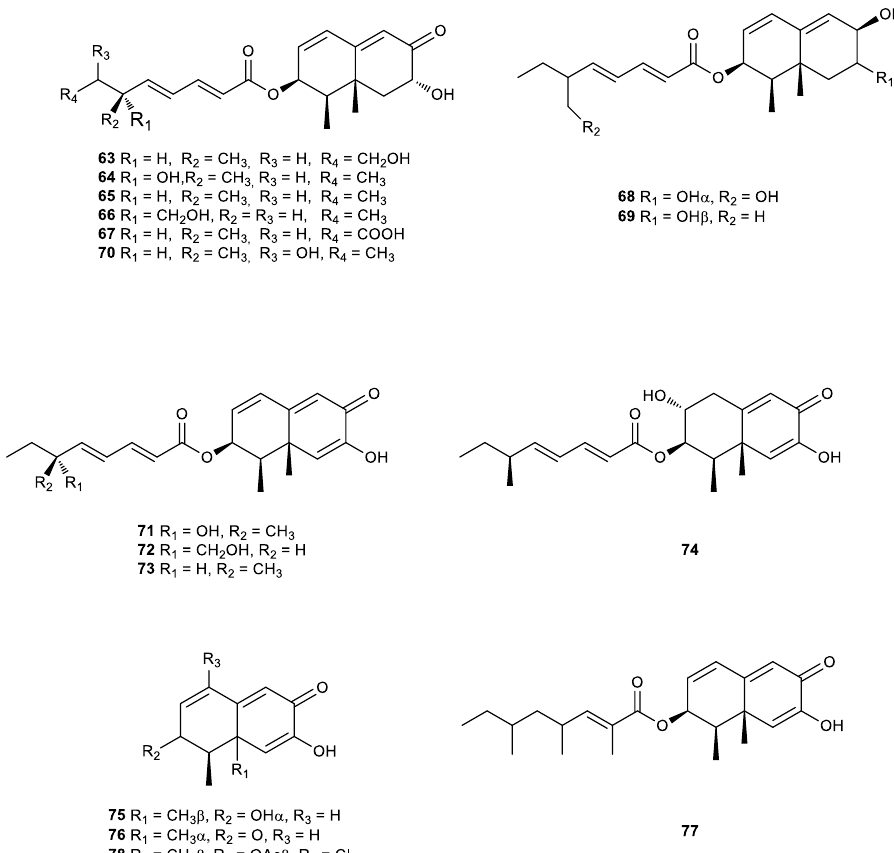
Figure 7. Molecular structure of 11,12,13-tri- nor -eremophilane